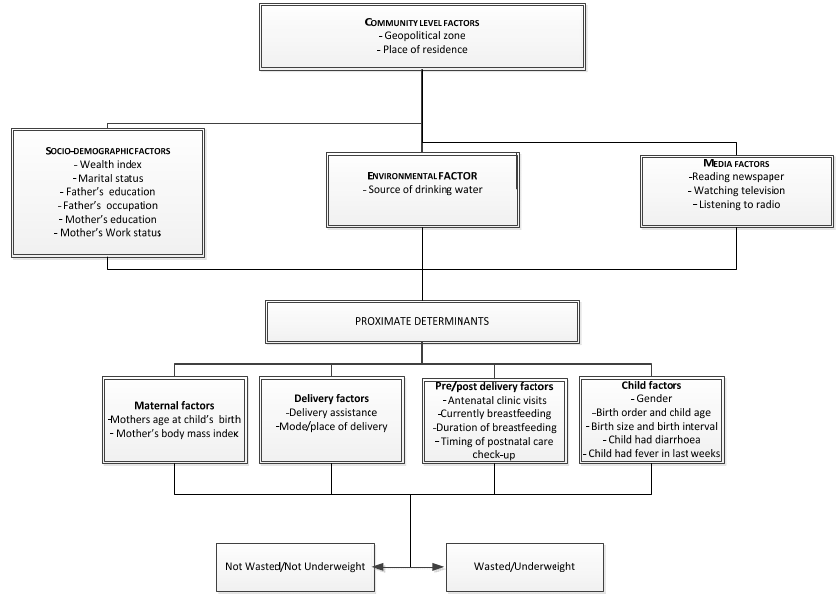
Figure 1. Conceptual framework for analysing factors associated with wasting/underweight and severe wasting/severe underweight in under ‐ five aged children in Nigeria.